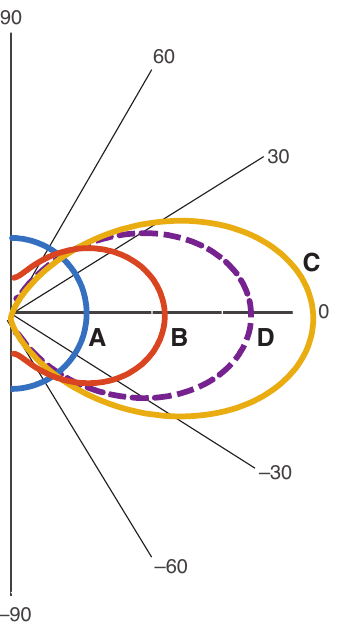
Figure 5: Angular distributions of carriers excited via different SPP decay mechanisms. (A) interband transitions and EE scattering-assisted transitions; (B) phonon/defect-assisted transitions; (C) Landau damping; (D) effective distribution combining carriers generated by Landau damping on the surface and the carriers generated in the bulk by phonon/defect-assisted transitions that have reached the